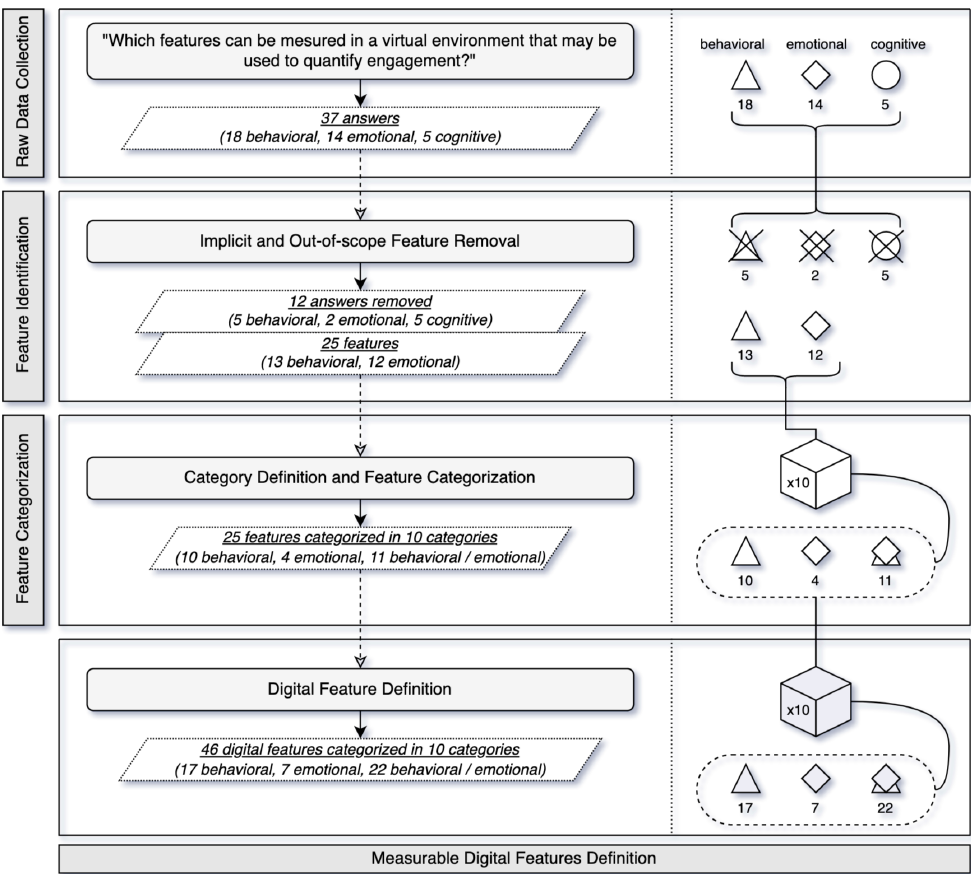
Figure 1. Methodological approach to model engagement in virtual learning